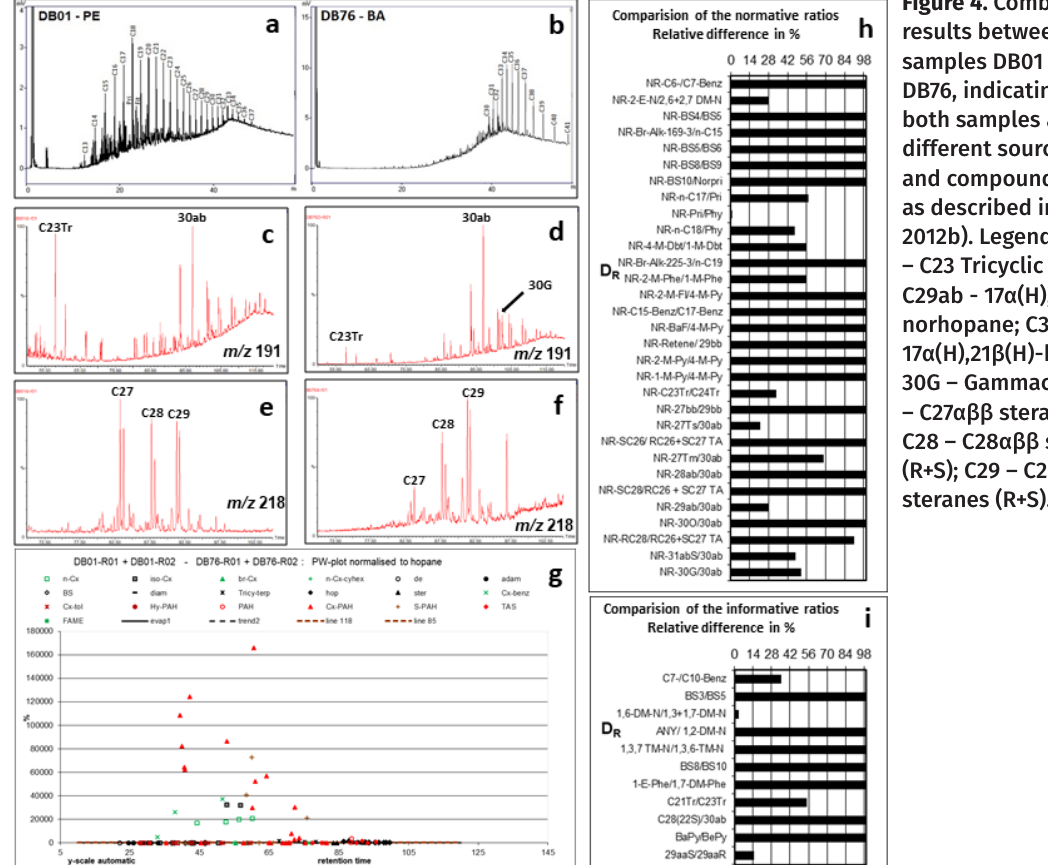
Figure 4. Combined results between samples DB01 and DB76, indicating that both samples are from different sources (DRs and compound